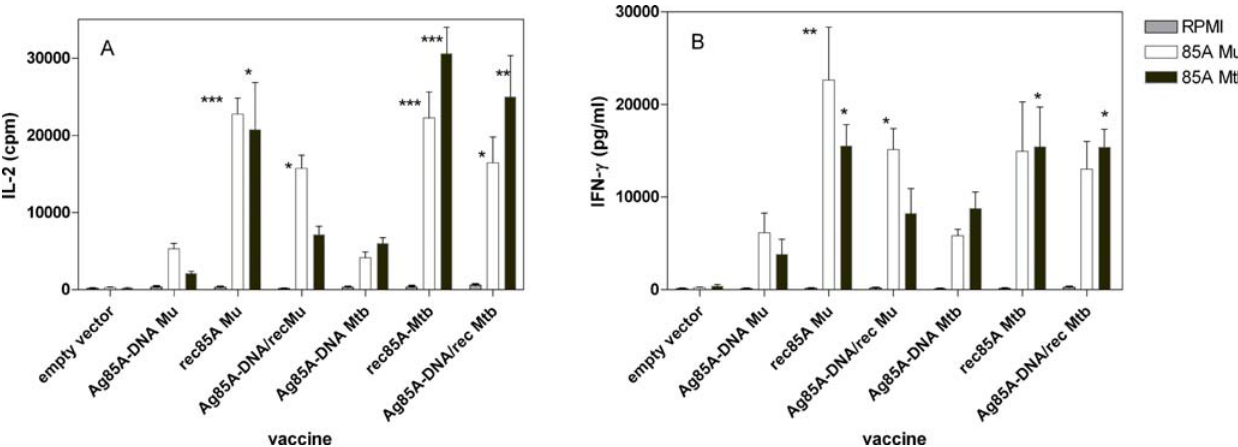
Figure 1. Spleen cell IL-2 (A) and IFN- c (B) responses to RPMI medium (grey bars), recombinant Ag85A from M.ulcerans (white bars) and M.tuberculosis (black bars) in B6 mice vaccinated with Ag85A DNA, Ag85A protein or Ag85A DNA boosted with protein in Gerbu adjuvant, 3 months after the third immunization. Cytokines levels tested on 24 h (IL-2) and 72 h (IFN- c ) culture supernatant of 4 mice tested individually/group. Data presented as means 6 SDs intra-assay. Statistically significant results as compared to the DNA vaccinated M. ulcerans or M. tuberculosis groups are represented in the figure by *** (P , 0.001), ** (P , 0.01) and * (P , 0.05). The first group of comparison take all of the vaccinated mice compared to the DNA vaccinated mice in response to recombinant Ag85A from M. ulcerans . The second group of comparison take